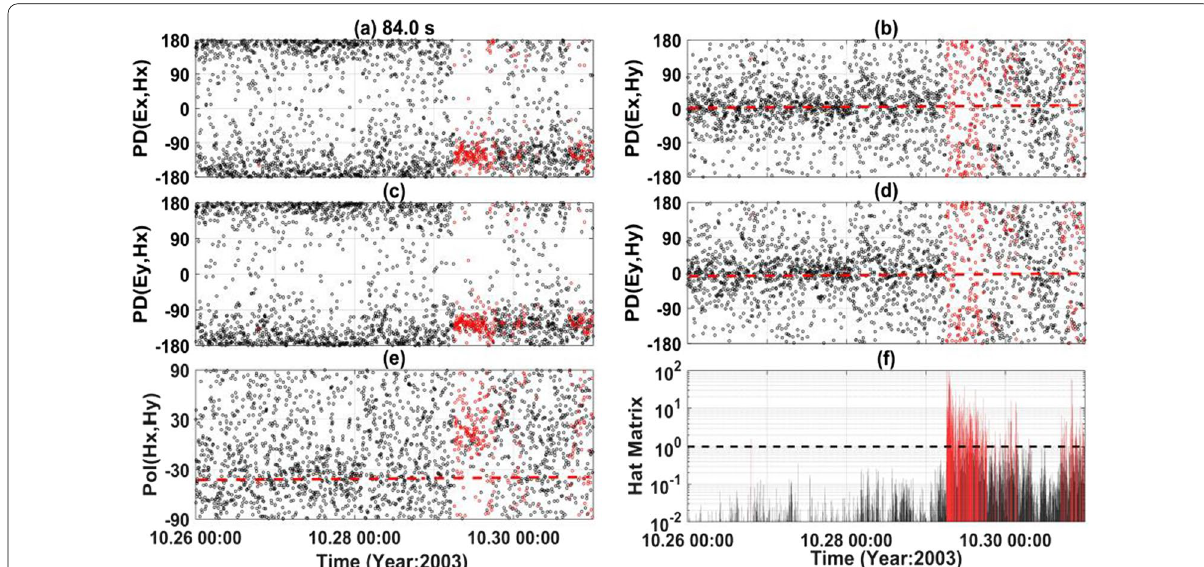
Fig. 10 Evaluation indices in the period of 84 s using the data observed at site 130 from 00:00 on October 26 to 00:00 on October 31. The data in red correspond to the leverage data associated with the storm. There are preferred directions of the phase difference between the electric and magnetic fields corresponding to the leverage data, as shown in a and c